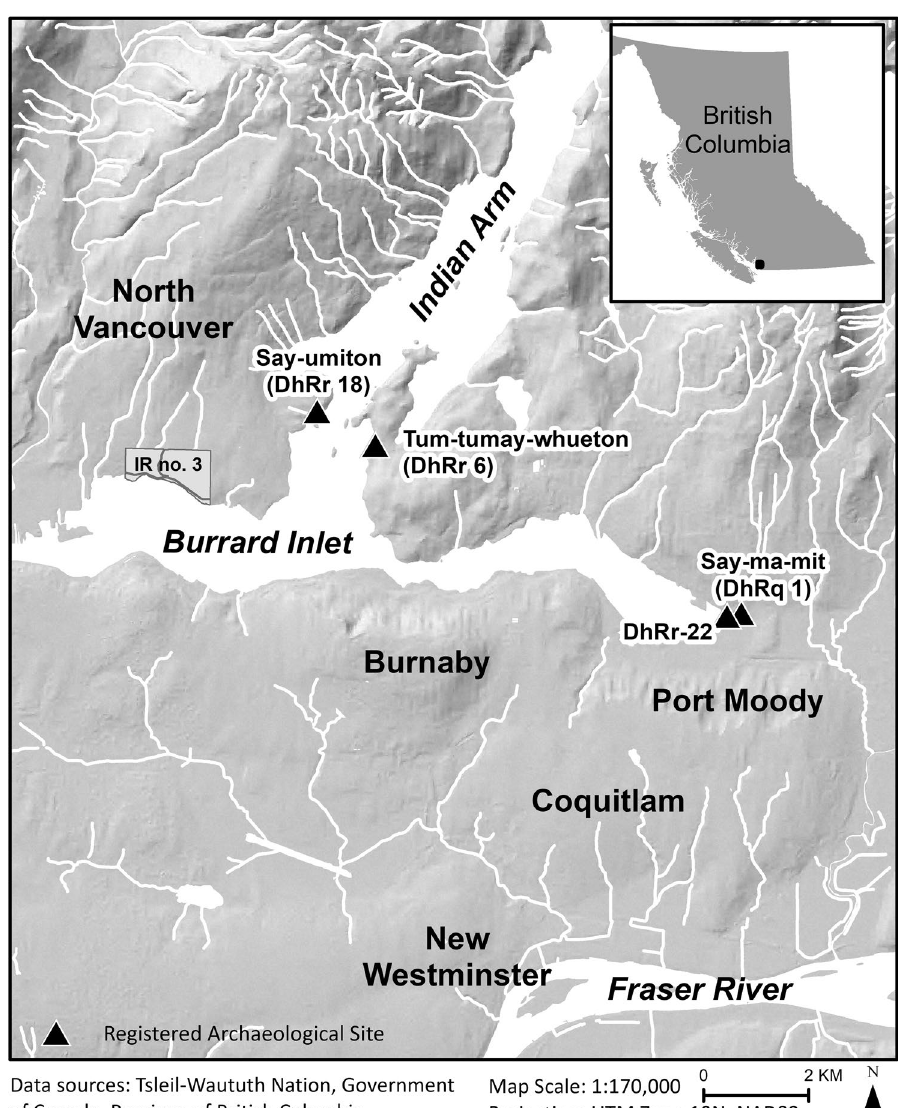
Figure 1. Burrard Inlet and the location of sampled archaeological sites. Figure created in ESRI ArcGIS version 10.8.1 (https:// www. esri.